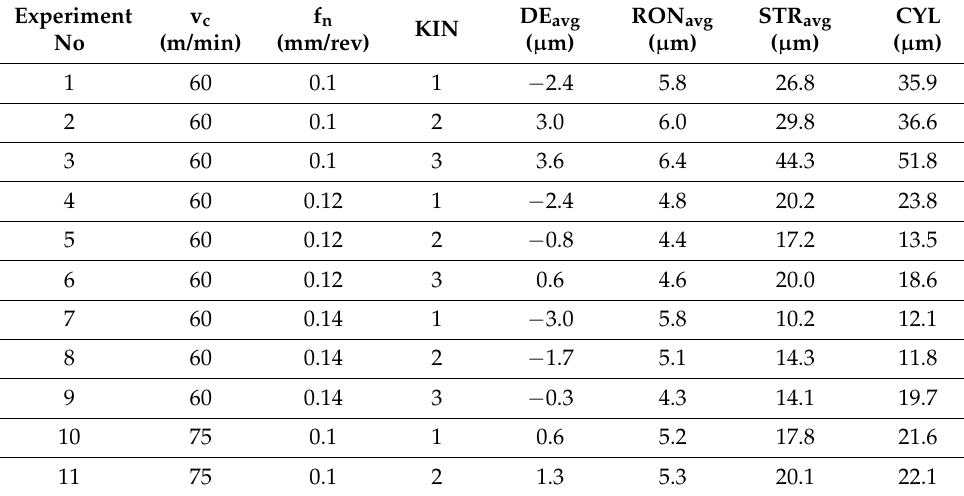
Table 4. Input parameters and the corresponding output values (calculated average